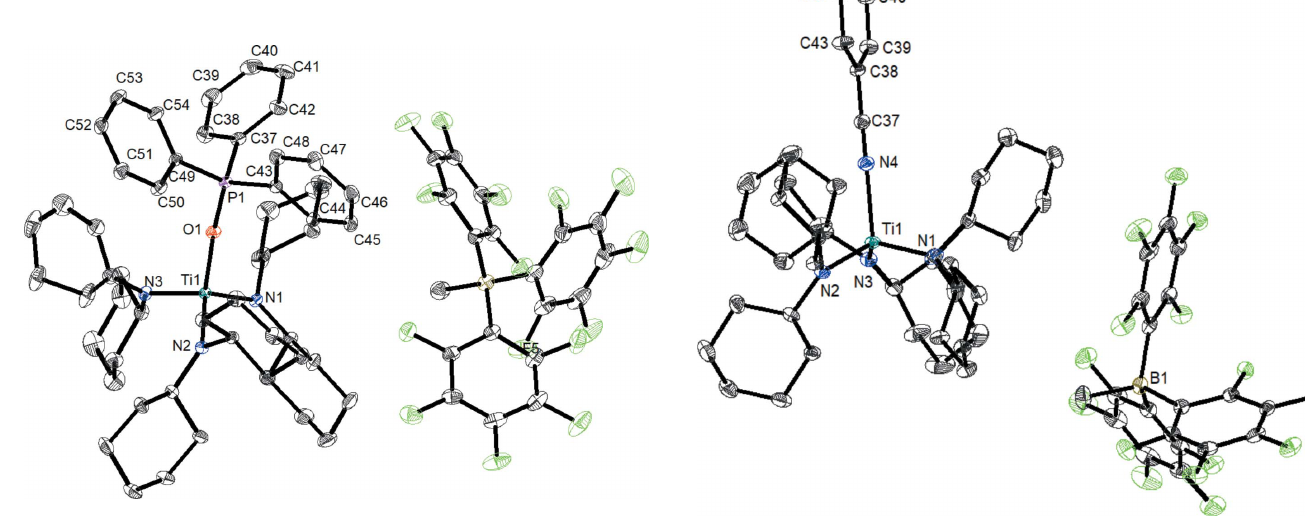
Figure 1 Molecular structure of compound ( 1 ). Displacement ellipsoids corre- spond to the 50% probability level. For clarity, only the major components of disordered parts are shown, and H atoms as well as solvent molecules have been